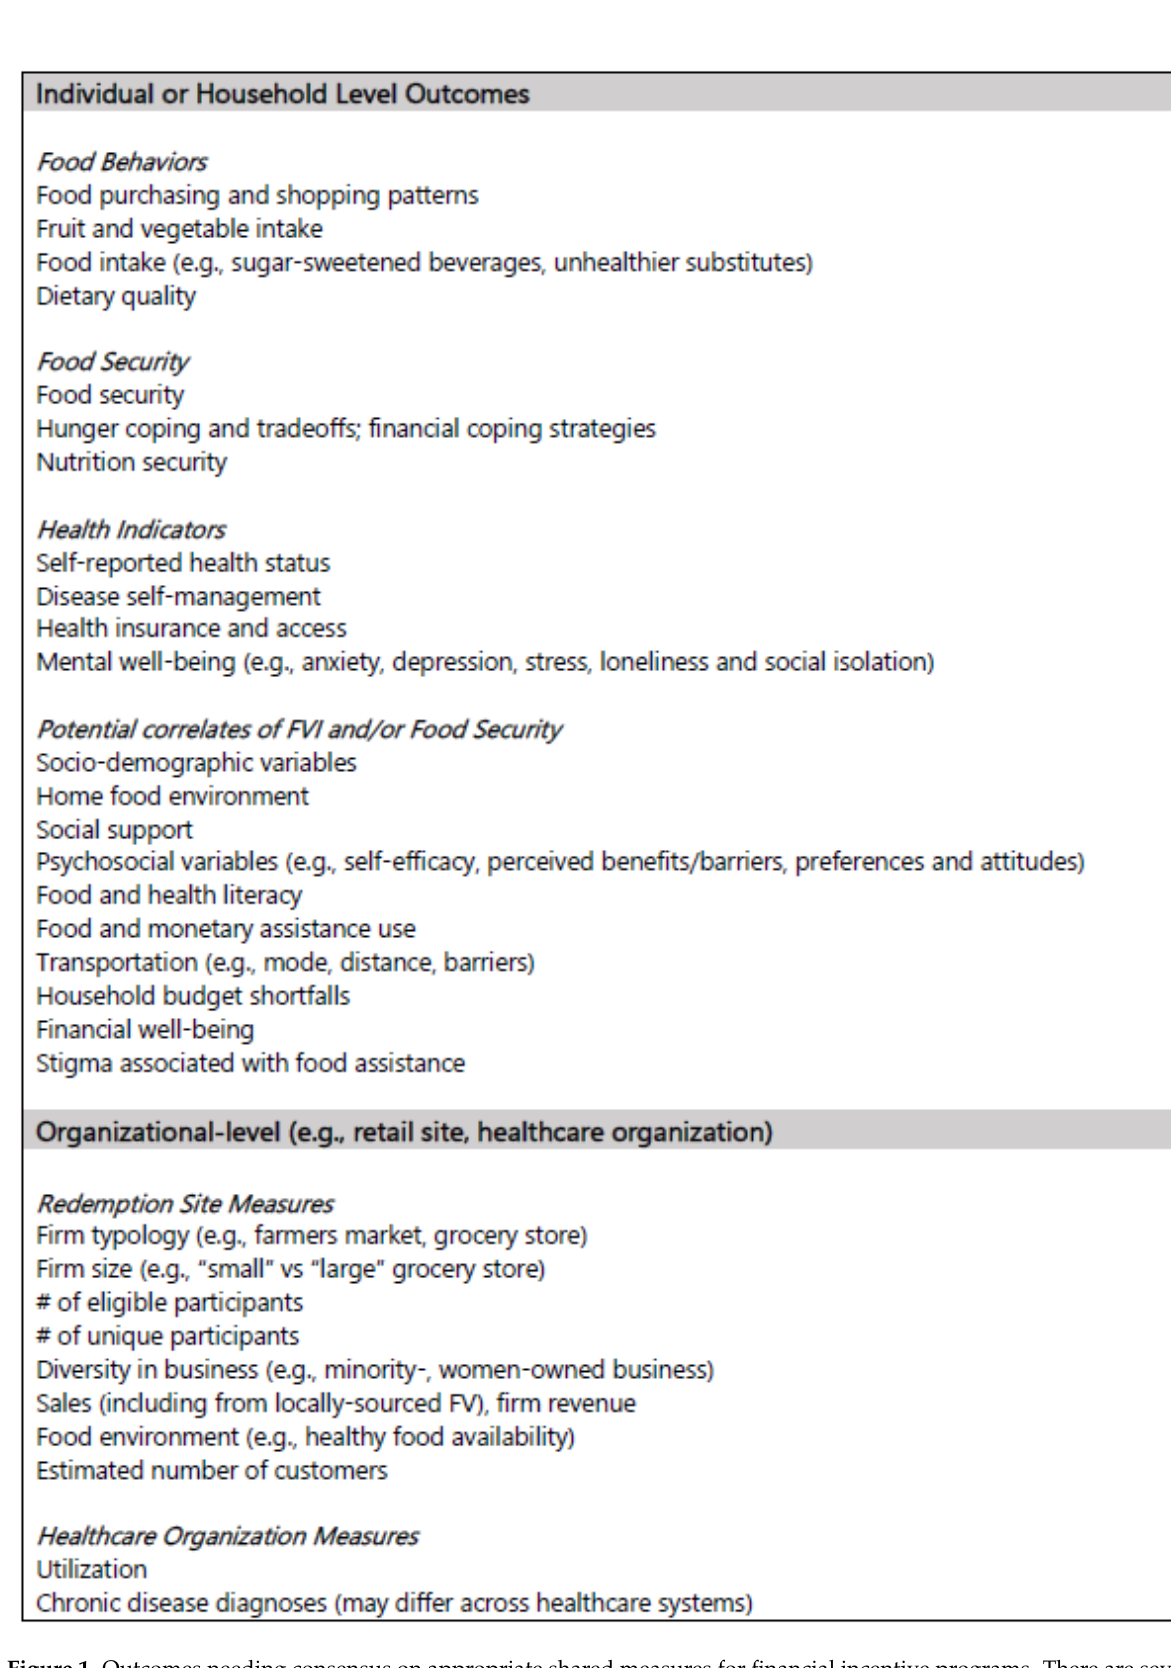
Figure 1. Outcomes needing consensus on appropriate shared measures for financial incentive programs. There are several other important outcomes than those listed here, however, those listed could benefit from a consensus on an appropriate shared measure.